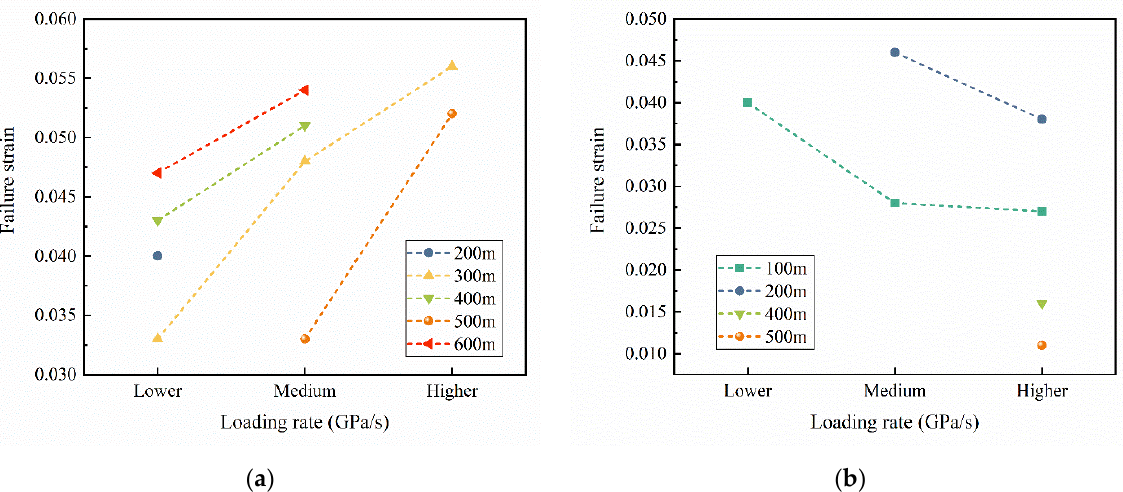
Figure 9. Failure strain and loading rate: ( a ) Relationship between failure strain and loading rate for incompletely fragmented specimens. ( b ) Relationship between failure strain and loading rate for completely fragmented specimens.